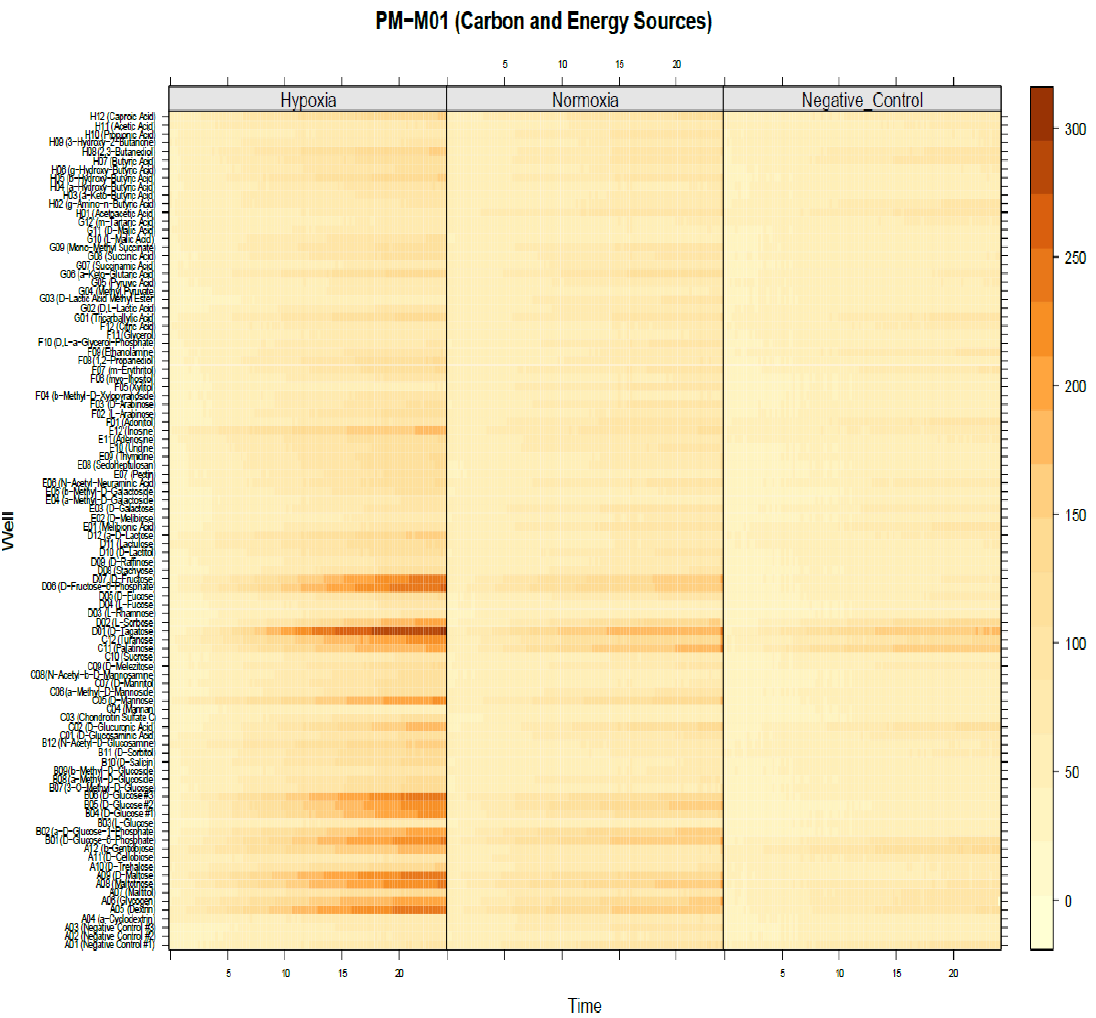
Figure 5. Heat map shows high energy production from carbon sources in hypoxia group in PM-M1. Time shown on the x-axis versus substrate names in each well on the y-axis. The Hypoxia group demonstrated high intensity (brown), which reflects the amount of nicotinamide adenine dinucleotide (NADH) energy that was utilized by MDA-MB-231 cells from chemical substrates. The Normoxia group showed that NADH production in MDA-MB-231 cells was less than that in the hypoxia group. The Negative control (without cells) group, composed of only medium plus DMOG without cells, revealed some abiotic reaction between chemical substrates and DMOG treatment. Heat map visualized and analyzed with OPM package.